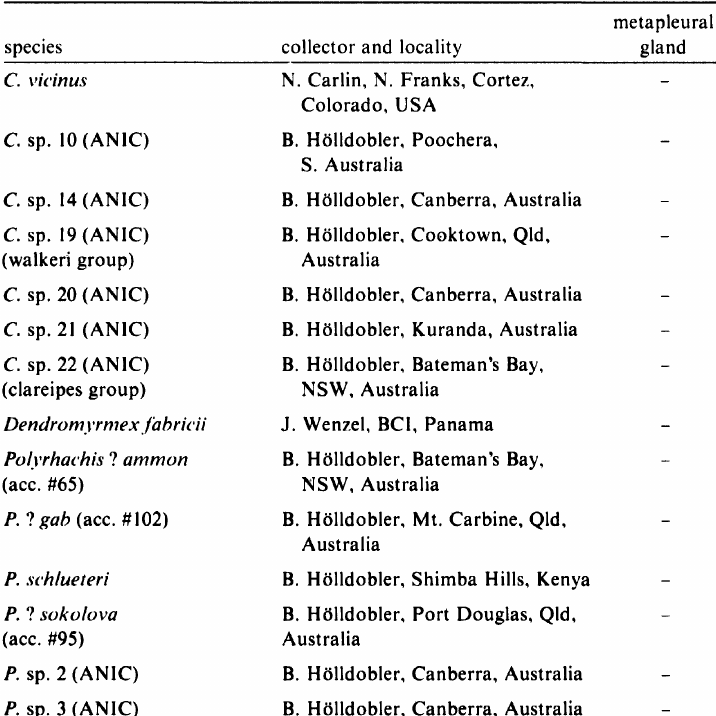
Table 2. (Continued) An external survey of the presence (+) or absence (-) of features that indicate a metapleural gland in the genera Camponolus, Dendro- m.l’rmex, and Pol.vrhachis. Further information concerning species identification see Table